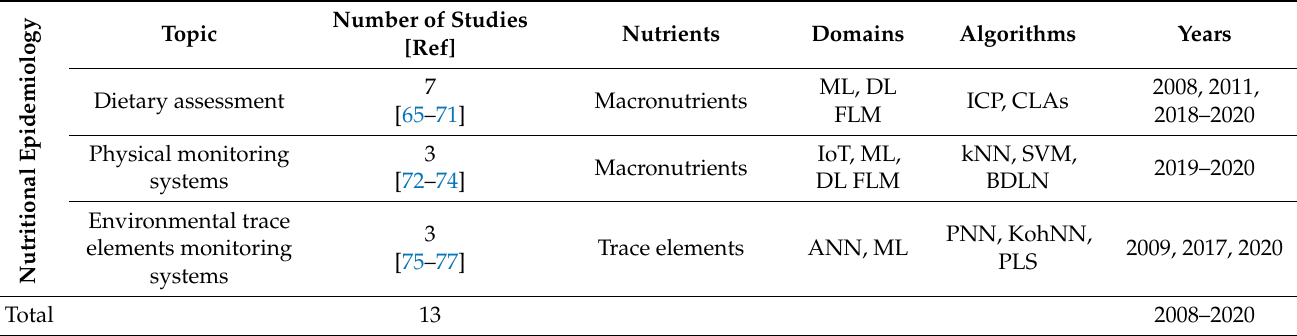
Table 3. The characteristics of the included studies on nutritional